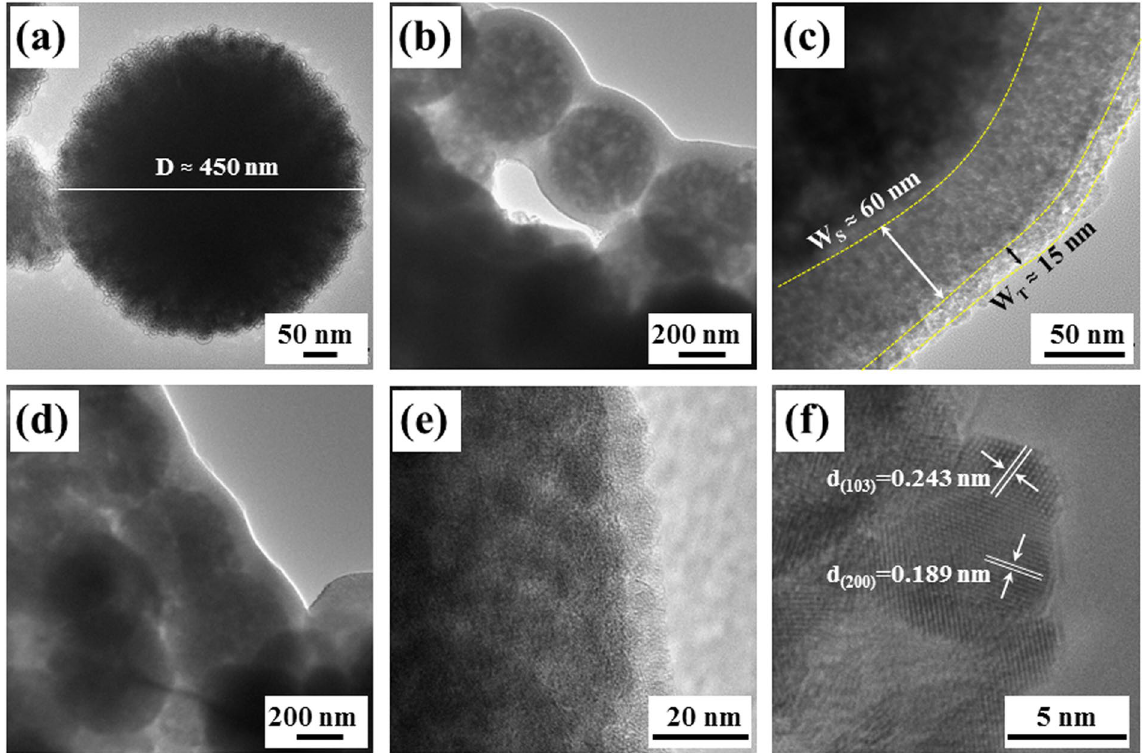
Figure 4. Typical HRTEM images of different samples: ( a ) Fe 3 O 4 , ( b , c ) Fe 3 O 4 @SiO 2 @TiO 2 , ( d – f ) γ -Fe 2 O 3 @